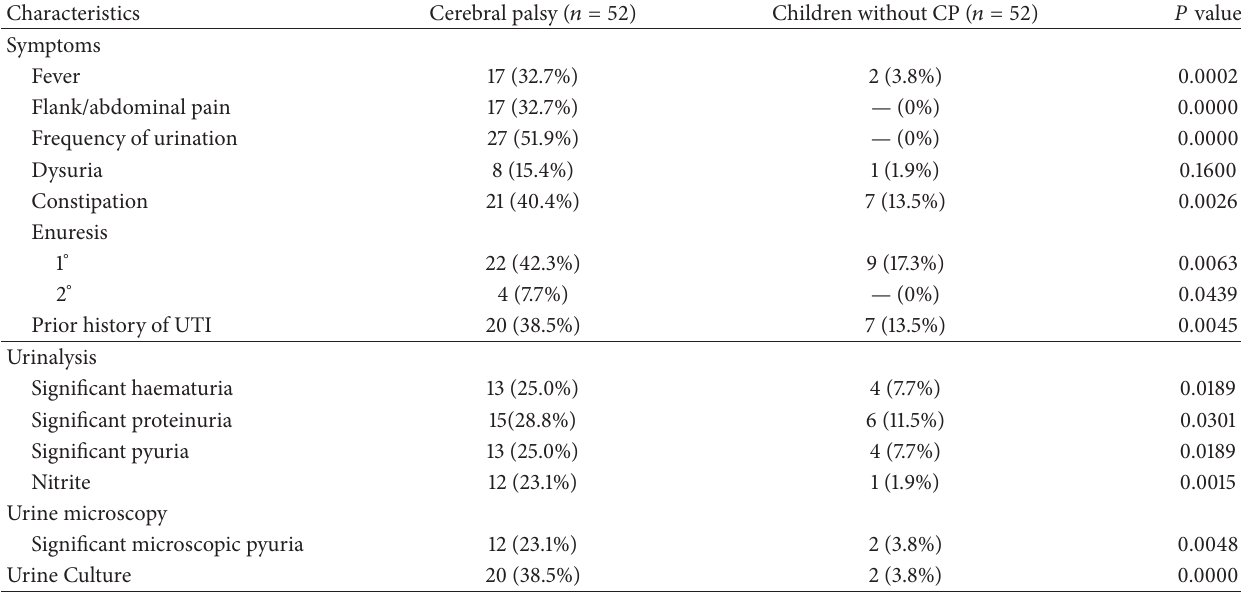
Table 2: Urinary symptoms, constipation, and urinalyses findings among subjects with cerebral palsy and controls without cerebral palsy. Characteristics